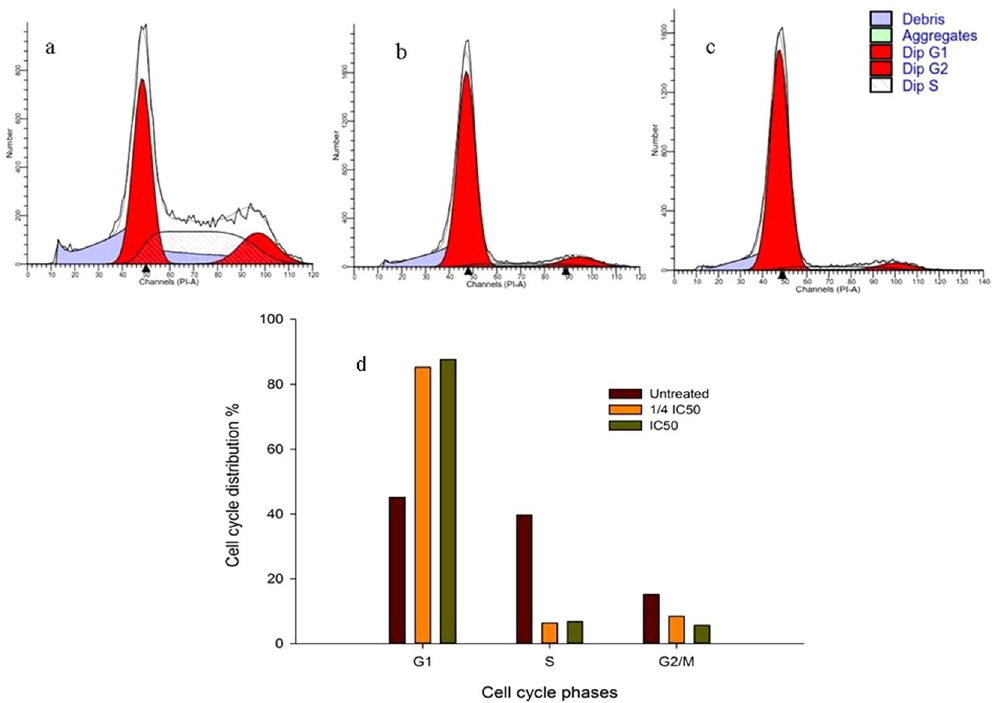
Figure 12. The cell cycle arrest caused by CPT-CEF in a concentration-dependent manner in HT29 cells. ( a ) Untreated, ( b ) 1/2 IC 50 treated cells and ( c ) IC 50 treated HT29 cells. ( d ) The graphical representation of the trend in cell cycle arrest of HT29 cells in response to CPT-CEF treatment.